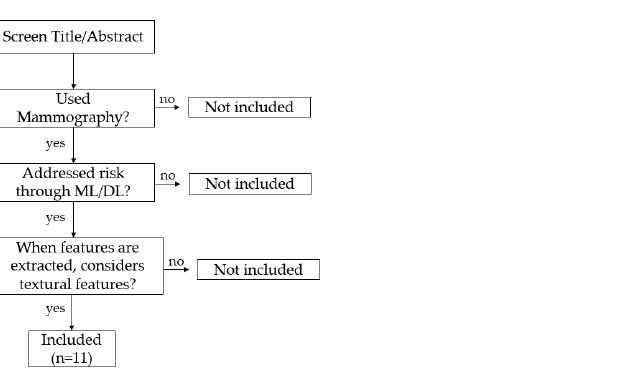
Figure 1. Paper Inclusion flowchart, for a search within the range 2000–2020 for publication date.